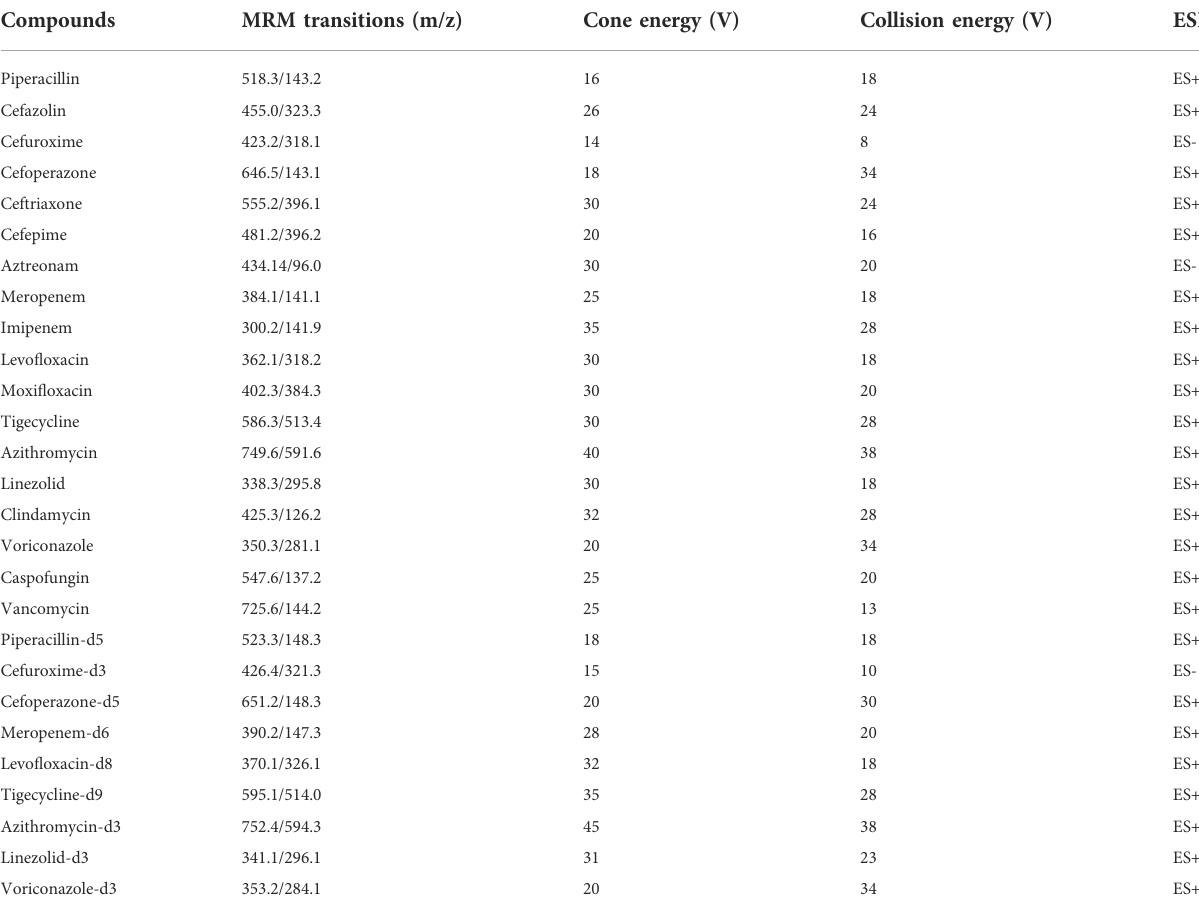
TABLE 1 Optimized multiple reaction monitoring parameters for 18 antimicrobial agents and nine ISs.